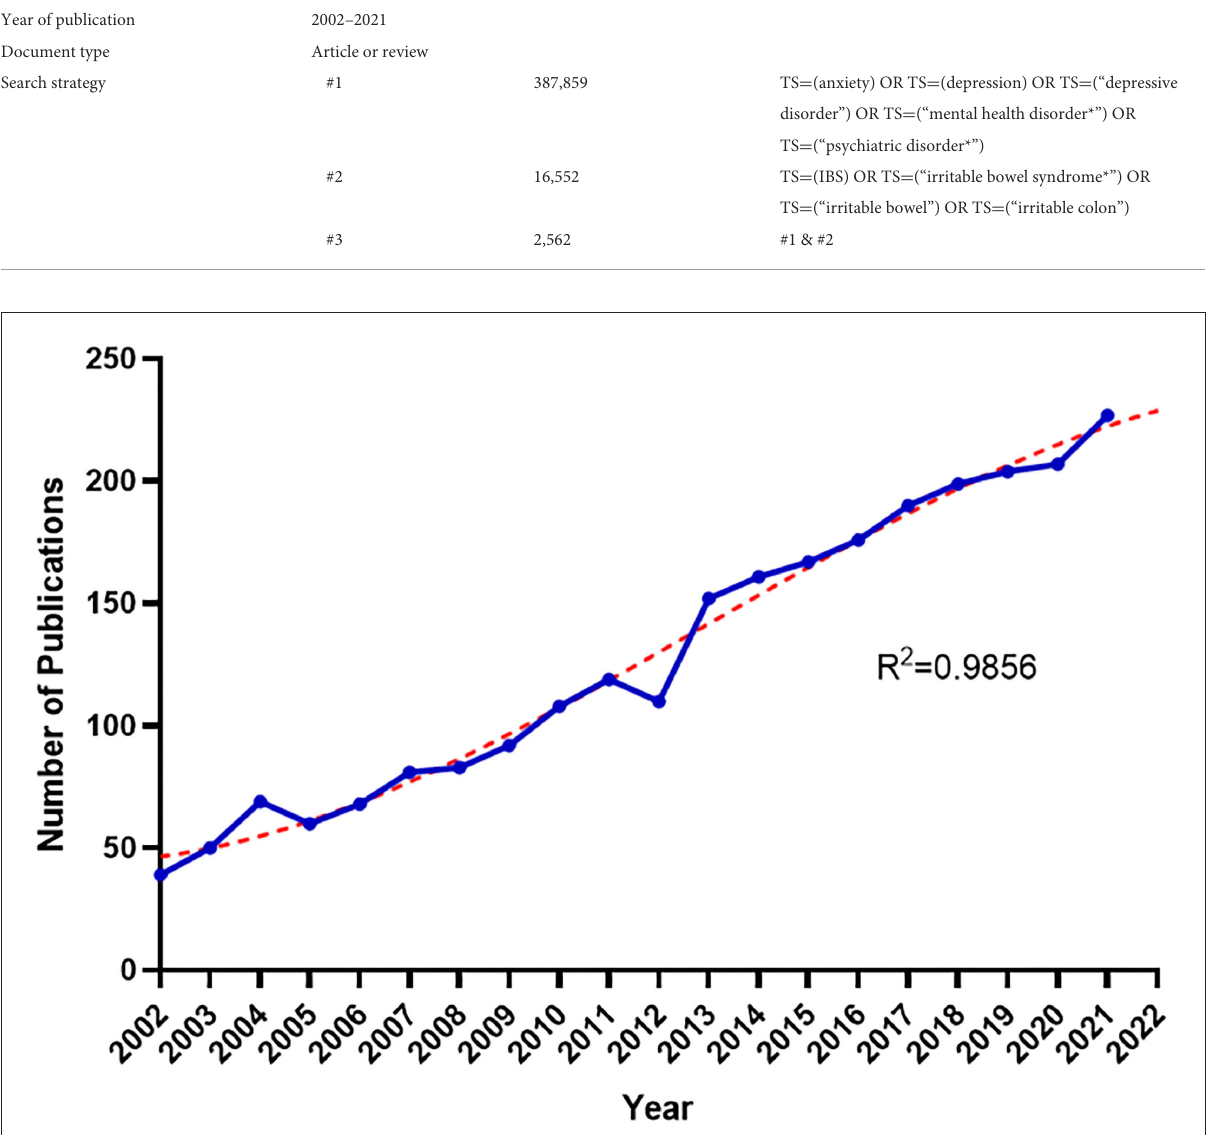
FIGURE1 Annual publications and growth forecast of IBS research related to anxiety or depression.